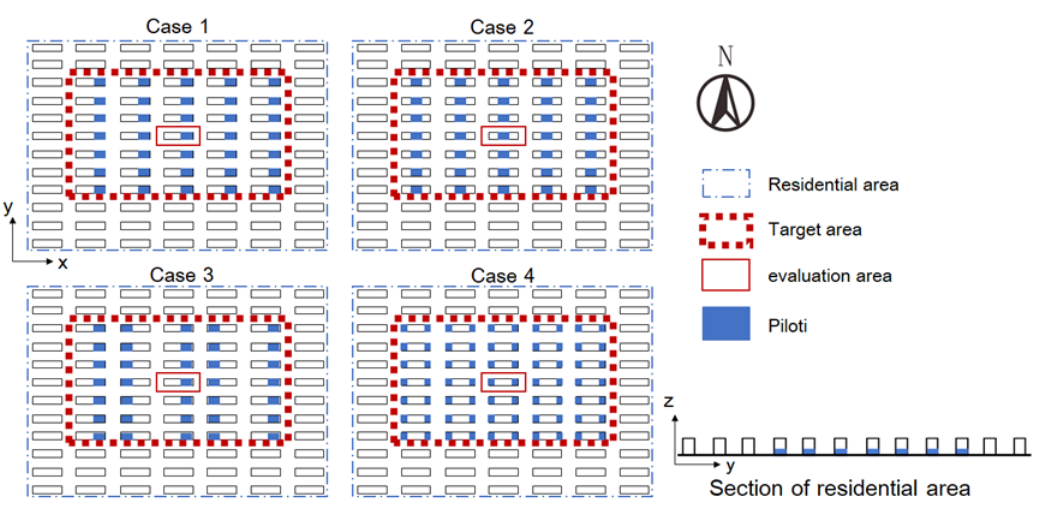
Figure 6. The piloti arrangements analysed for the study area. Table 8. The details of the pilotis arrangements analysed in the study